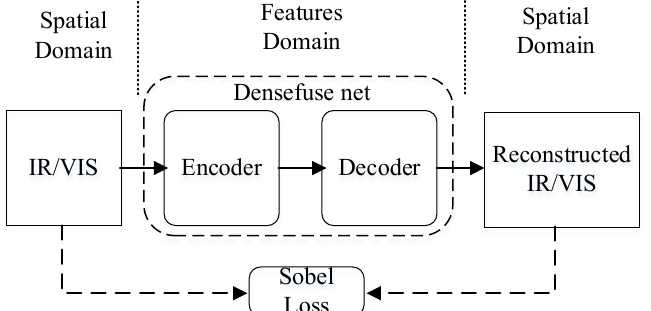
Figure 3. The training process of the proposed method. Dashed lines represent the data used in the Sobel loss.